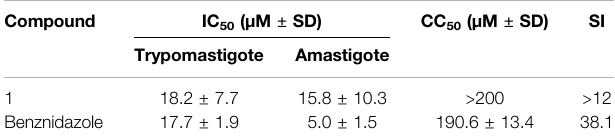
TABLE 1 | - Anti – T. cruzi activity and mammalian cytotoxicity of compound 1 (T-cadinol).